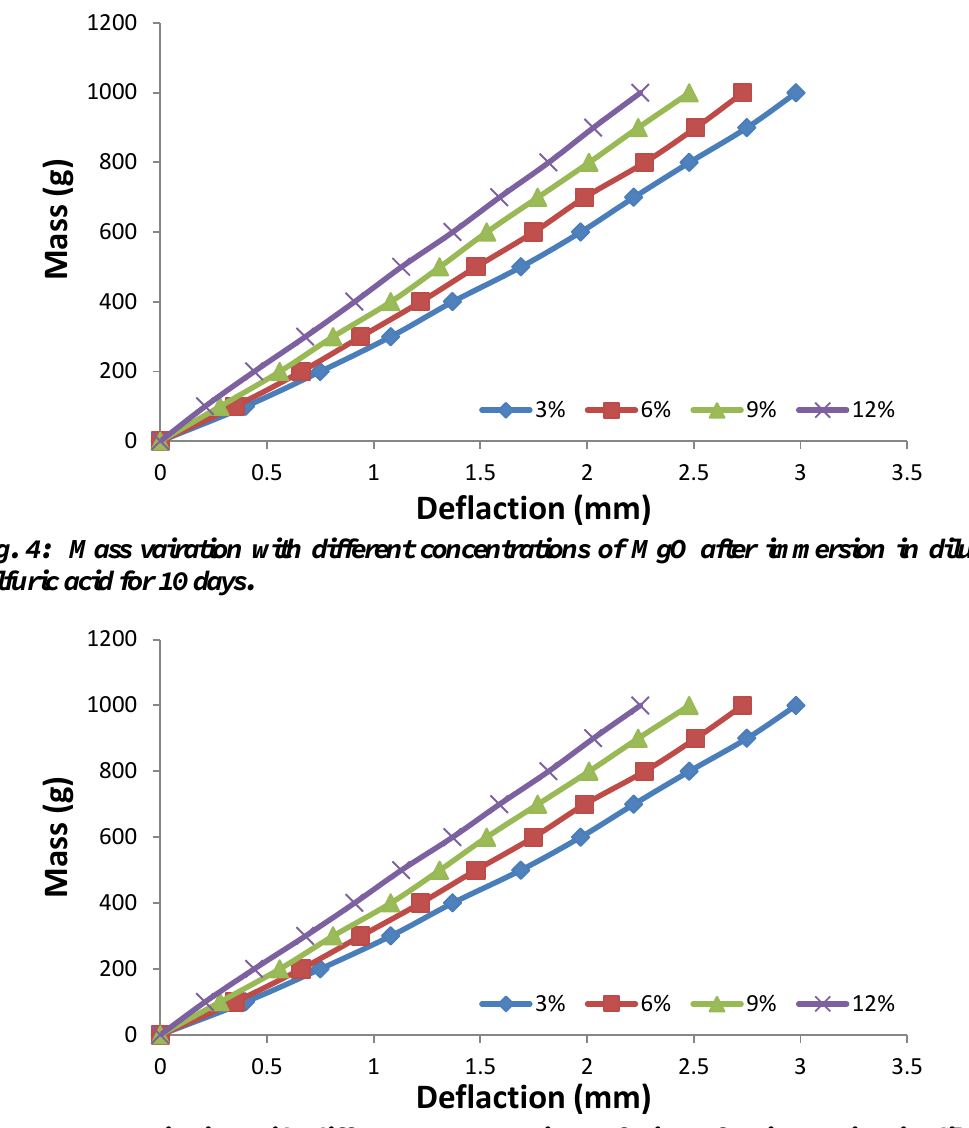
after immersion in diluted 2